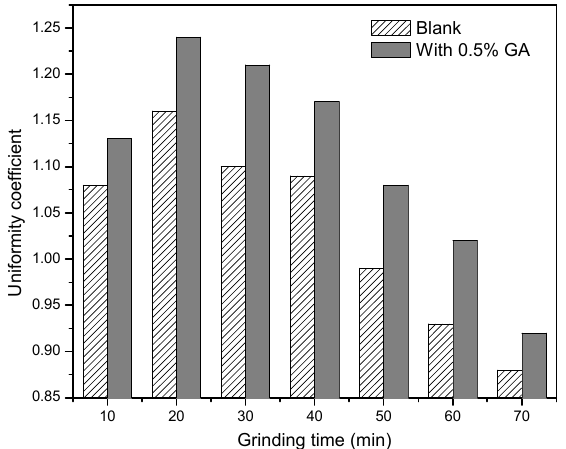
Figure 10. Uniformity coefficient of steel slag powder with GA vs. grinding time. Table 6. Particle size distribution of steel slag powder with GA under different grinding time (%). Without GA With GA Grinding time (min)